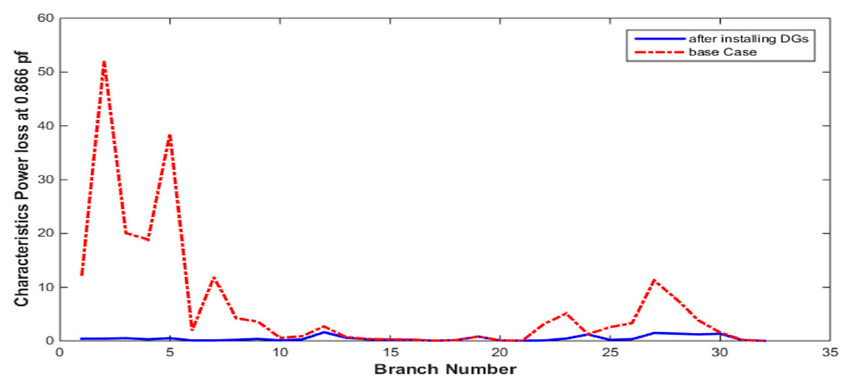
Figure 14. Characteristics of power loss, 33-bus system at 0.866 pf.